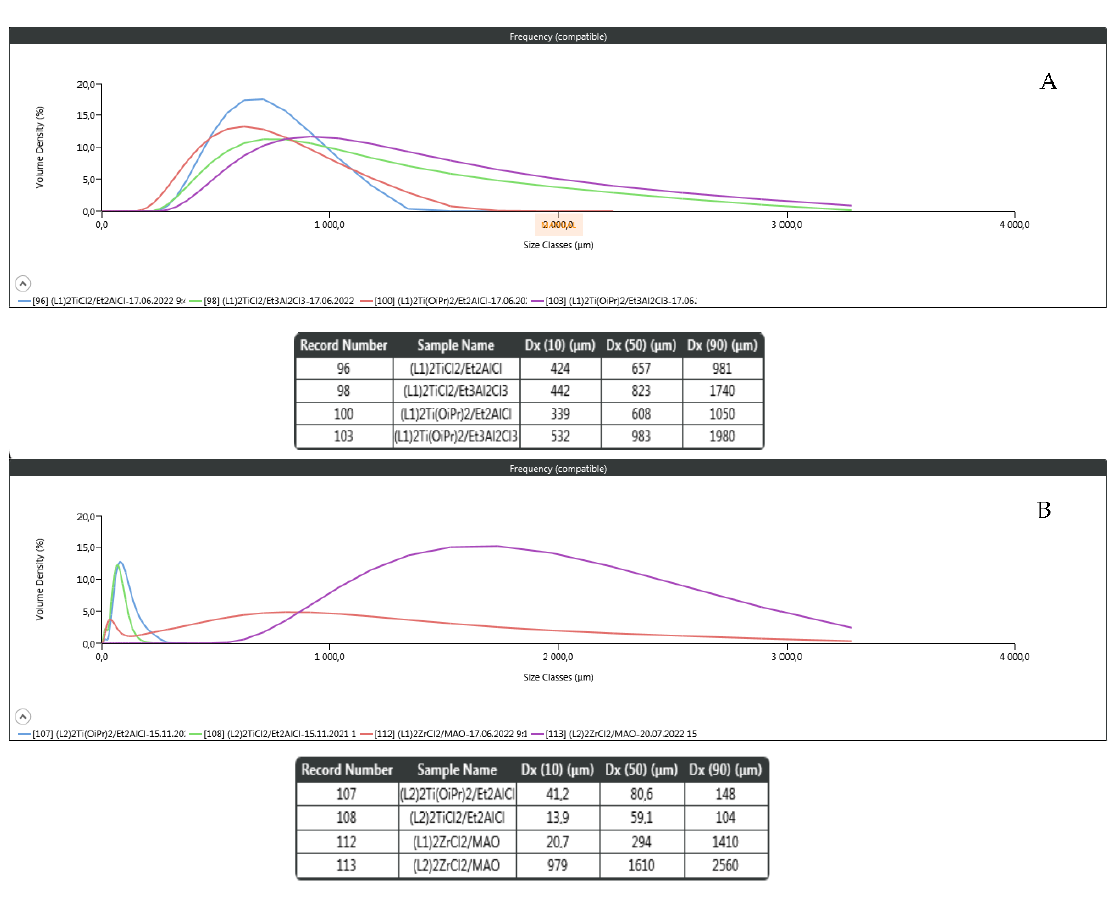
Table 2. Mechanical properties of UHMWPE oriented film tapes a.